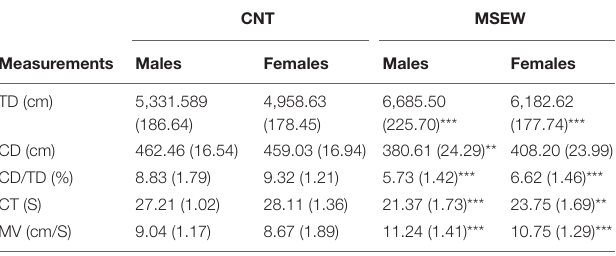
TABLE 1 | Performance of adult rats in open-field